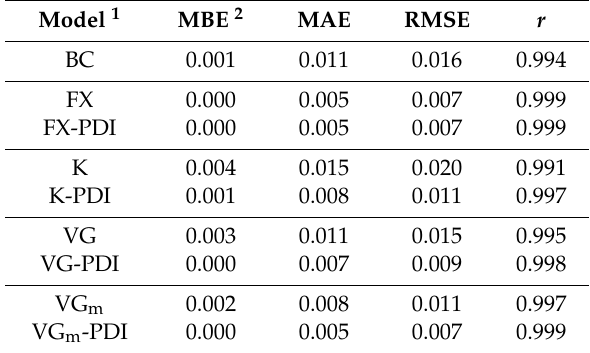
Table 3. Overall performance of the unimodal and PDI models for the entire data